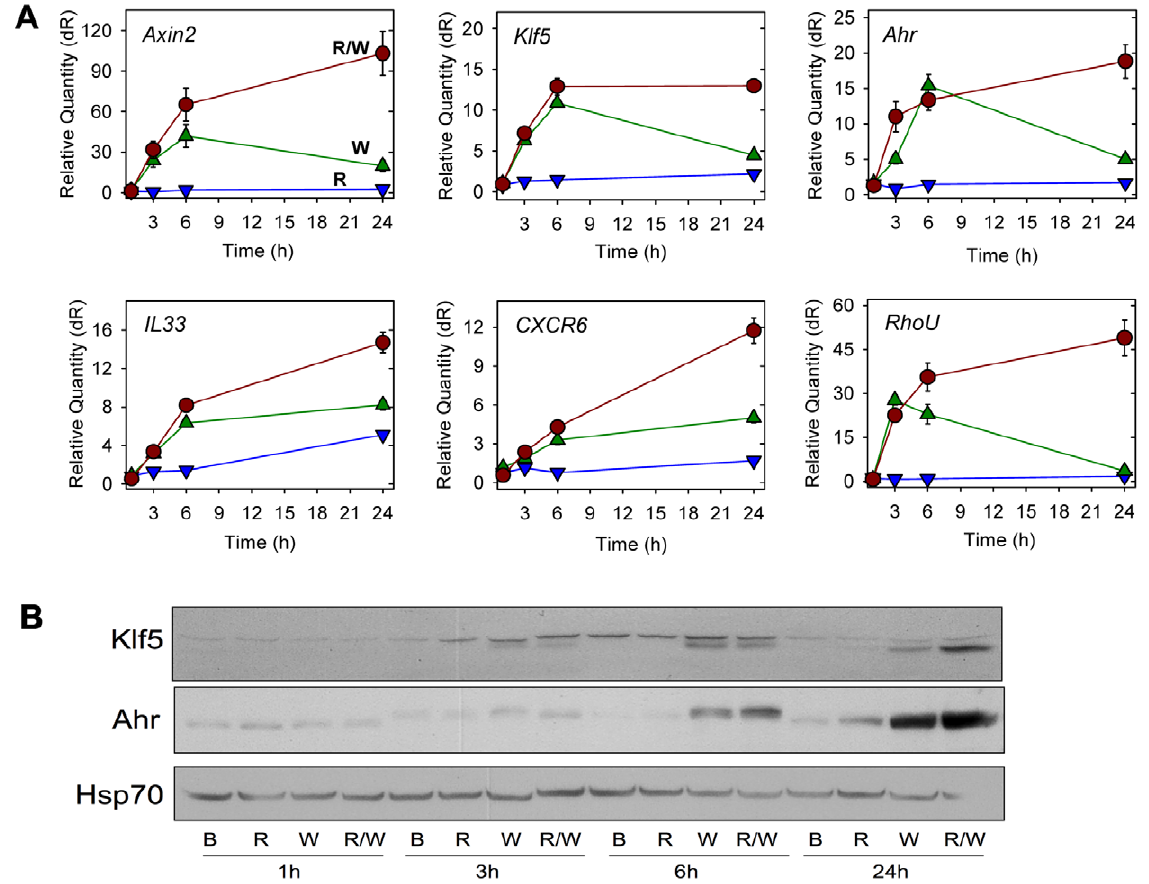
Figure 2. Time-course of Rspo2- and Wnt3a-dependent gene up-regulation in C57MG cells. ( A ) Quantitative RT-PCR analysis of specific gene expression in response to Rspo2 (100 ng/ml) alone (blue), Wnt3a (100 ng/ml) alone (green) or the two together (red) at the indicated time points. Data are the means + / 2 S.D. (error bars, sometimes too small to see) of triplicate measurements from one of several experiments with similar results. ( B ) Immunoblot analysis of Klf5 and Ahr protein expression following treatment with BSA carrier, Rspo2 (100 ng/ml), Wnt3a (100 ng/ml) alone or in combination for the indicated periods. Membranes were re-probed for Hsp70 as a loading control.